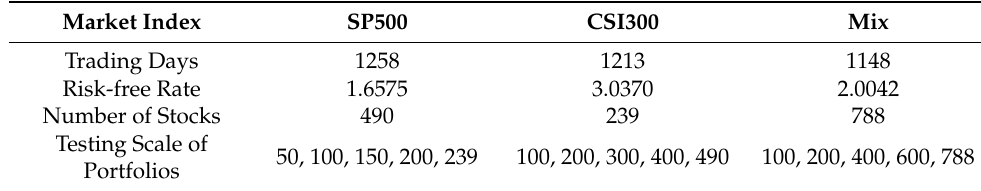
Table 5. The Descriptions of Portfolio Optimization